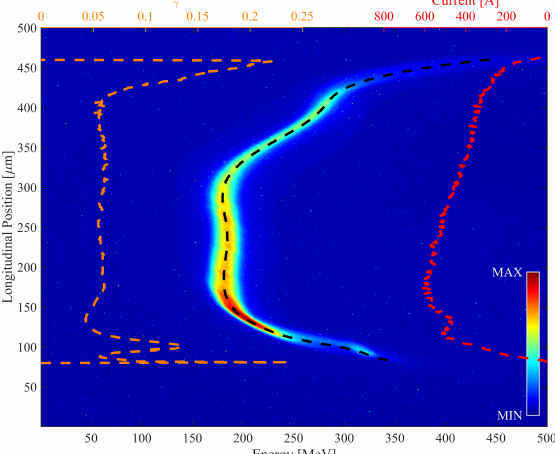
Figure 5. The measured longitudinal phase space without lasing. The black, orange, and red lines represent the centroid energy, energy spread, and current, respectively.